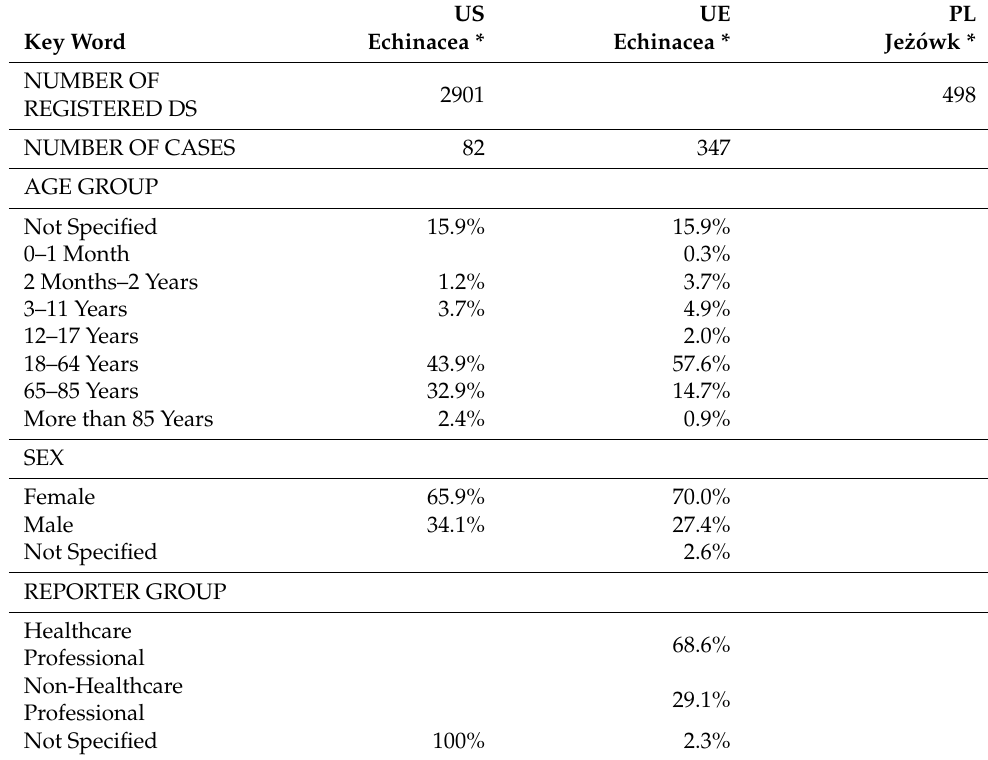
Table 6. Comparison of data on Echinacea from different